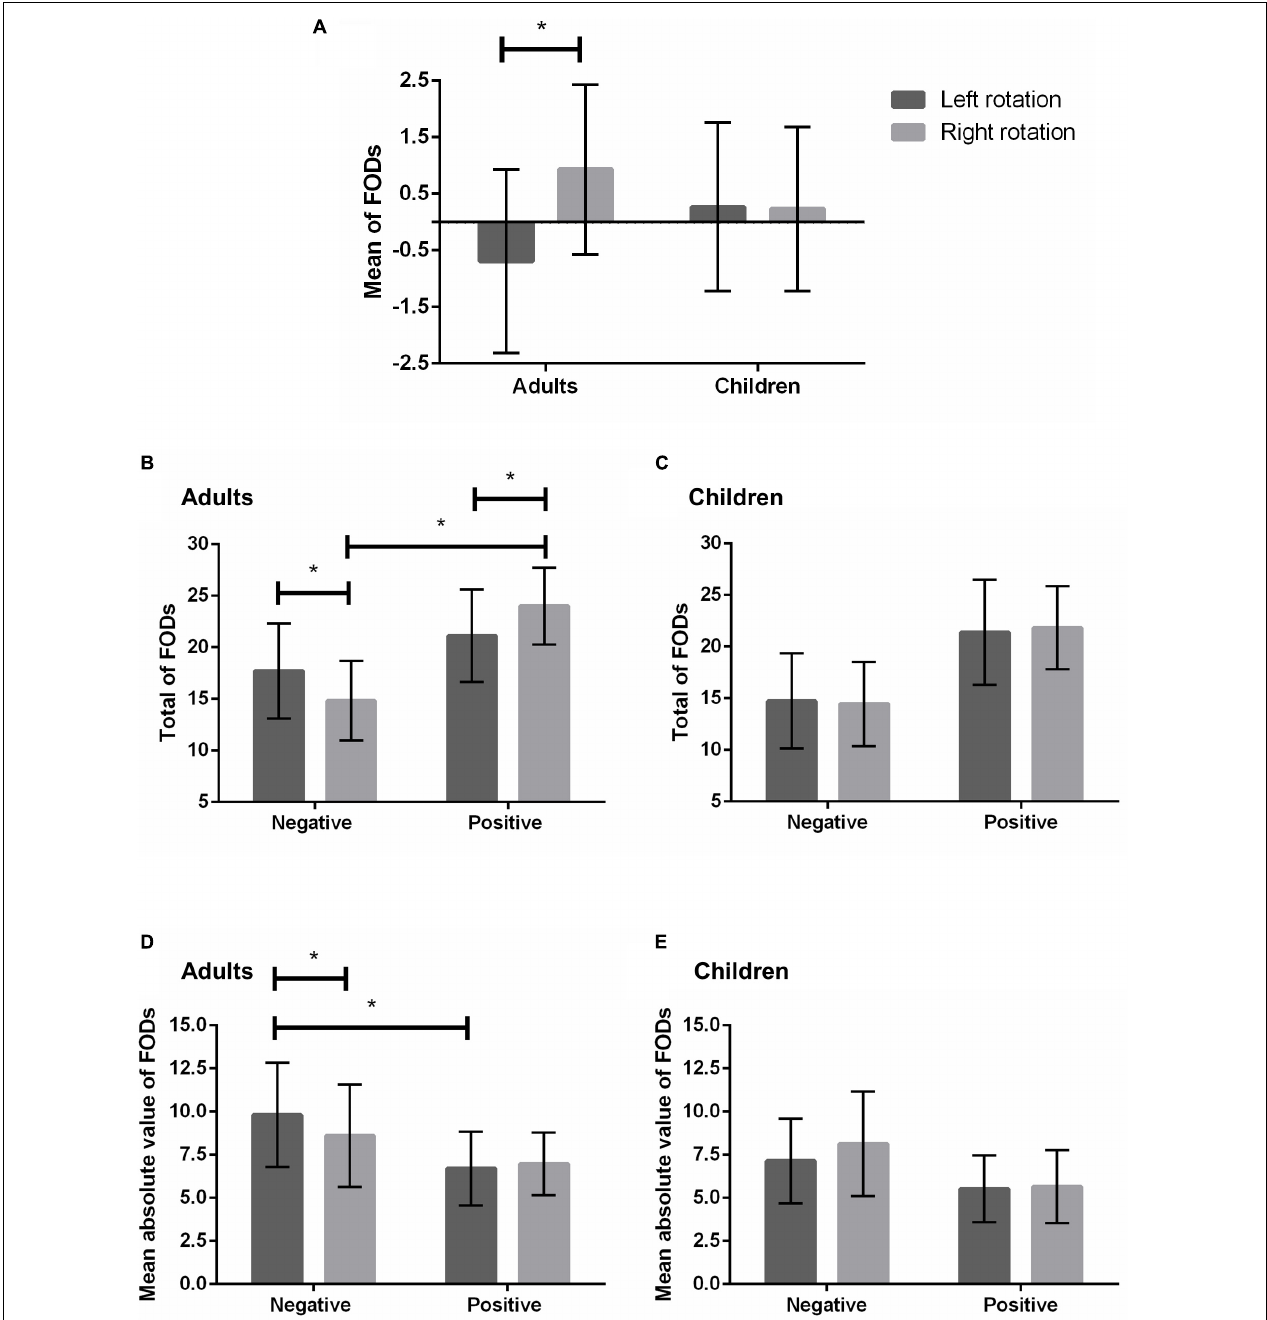
FIGURE 2 | First order differences as a function of left/right rotation in adults and children. The mean of FODs (A) . The total of negative and positive FODs in adults (B) and children (C) . The mean absolute value of negative and positive FODs in adults (D) and children (E) . Error bars represent standard deviation. Asterisks denote statistical significance ( ∗ p <